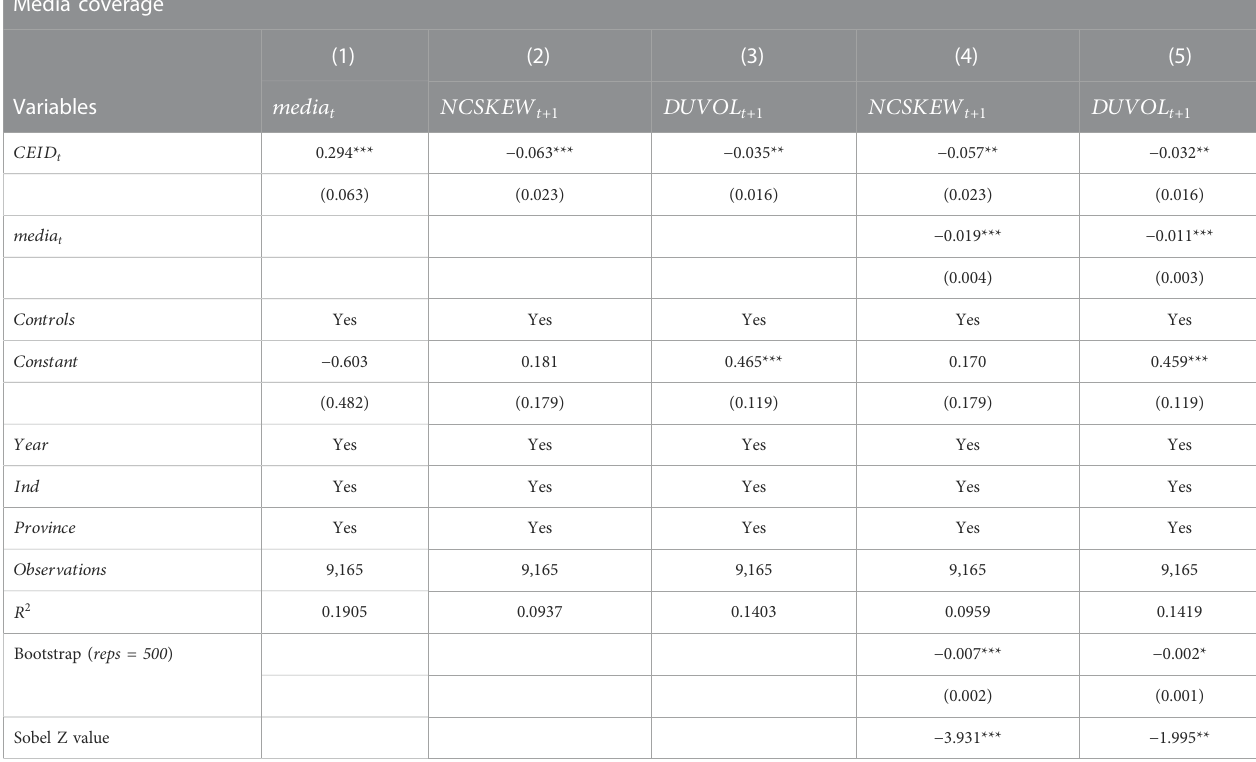
TABLE 4 Mechanism